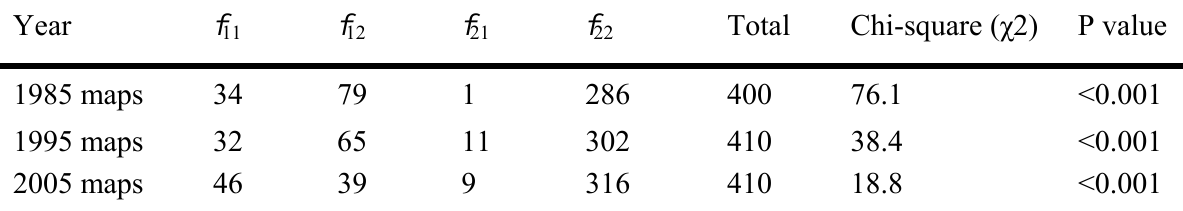
Table 4. McNemar’s test showing the superiority of PCC maps vs. MLC